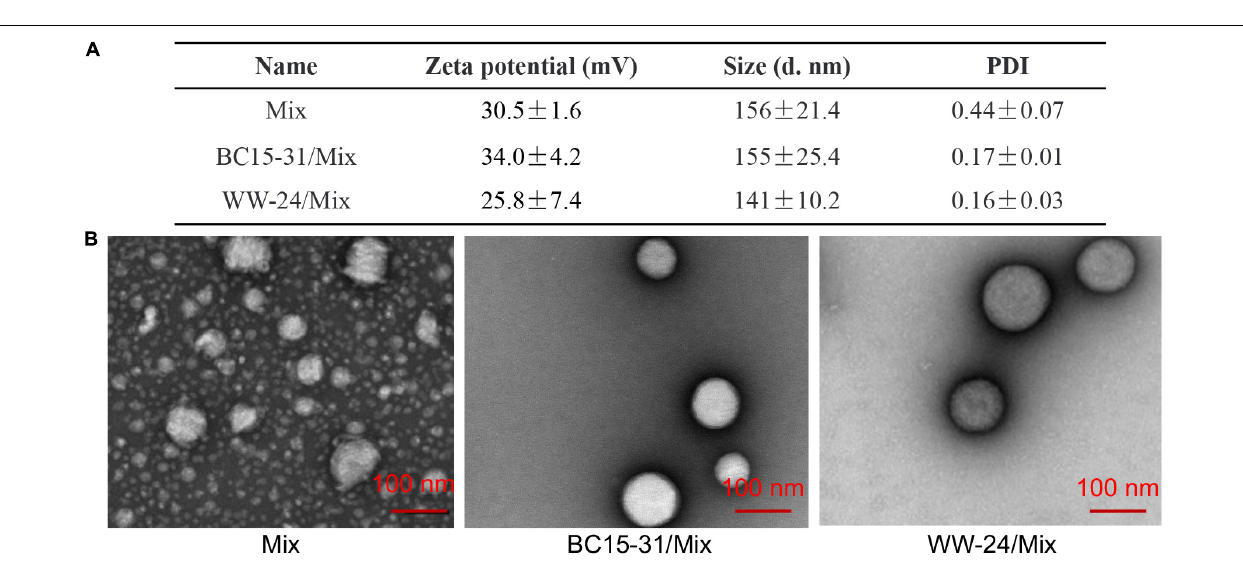
FIGURE 3 | Characterization of DNCA/CLD/aptamer liposomes. (A) The size, zeta potential, and PDI of the nanocomplexes. (B) TEM result of DNCA/CLD/aptamer nanoparticles (DNCA/CLD/nt: 1/1/1; aptamers: 10 µ